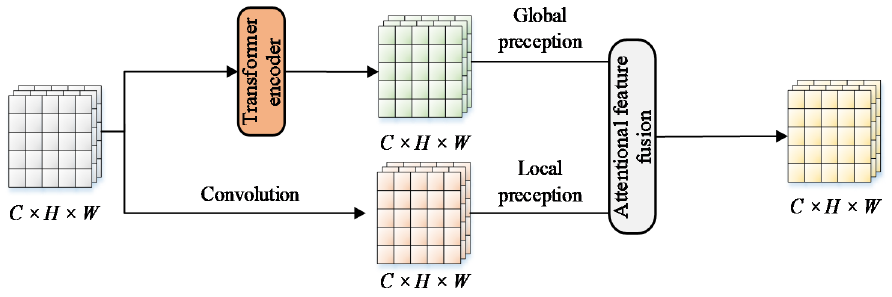
Figure 6. Structure of feature fusion-based CSP (CSP-FF).